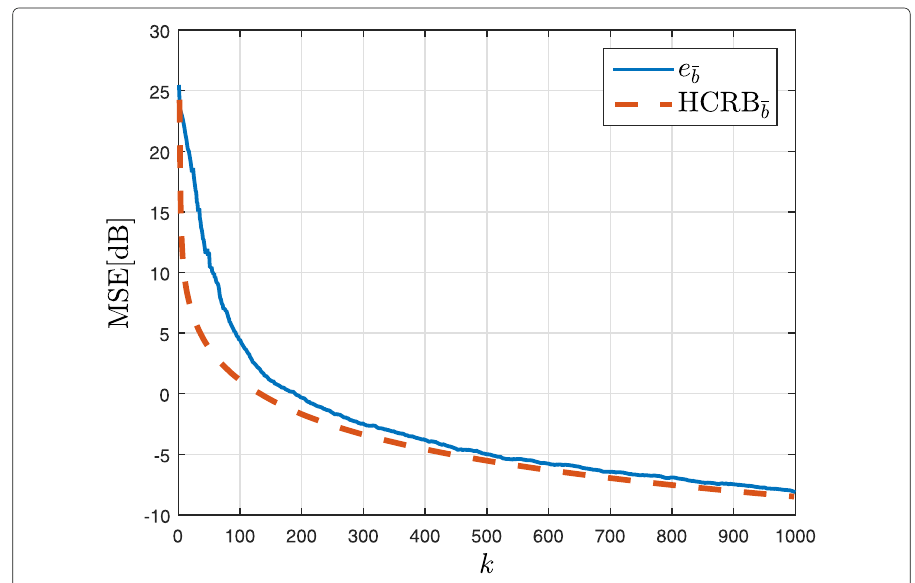
Fig. 4 Mean square error for the estimation of the wall offset b . The solid line depicts e ¯ the dashed line is the HCRB